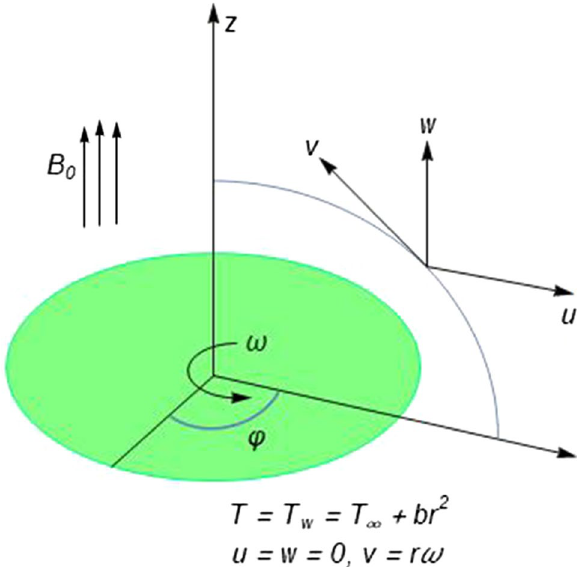
Figure 1. Geometry of the problem and coordinate